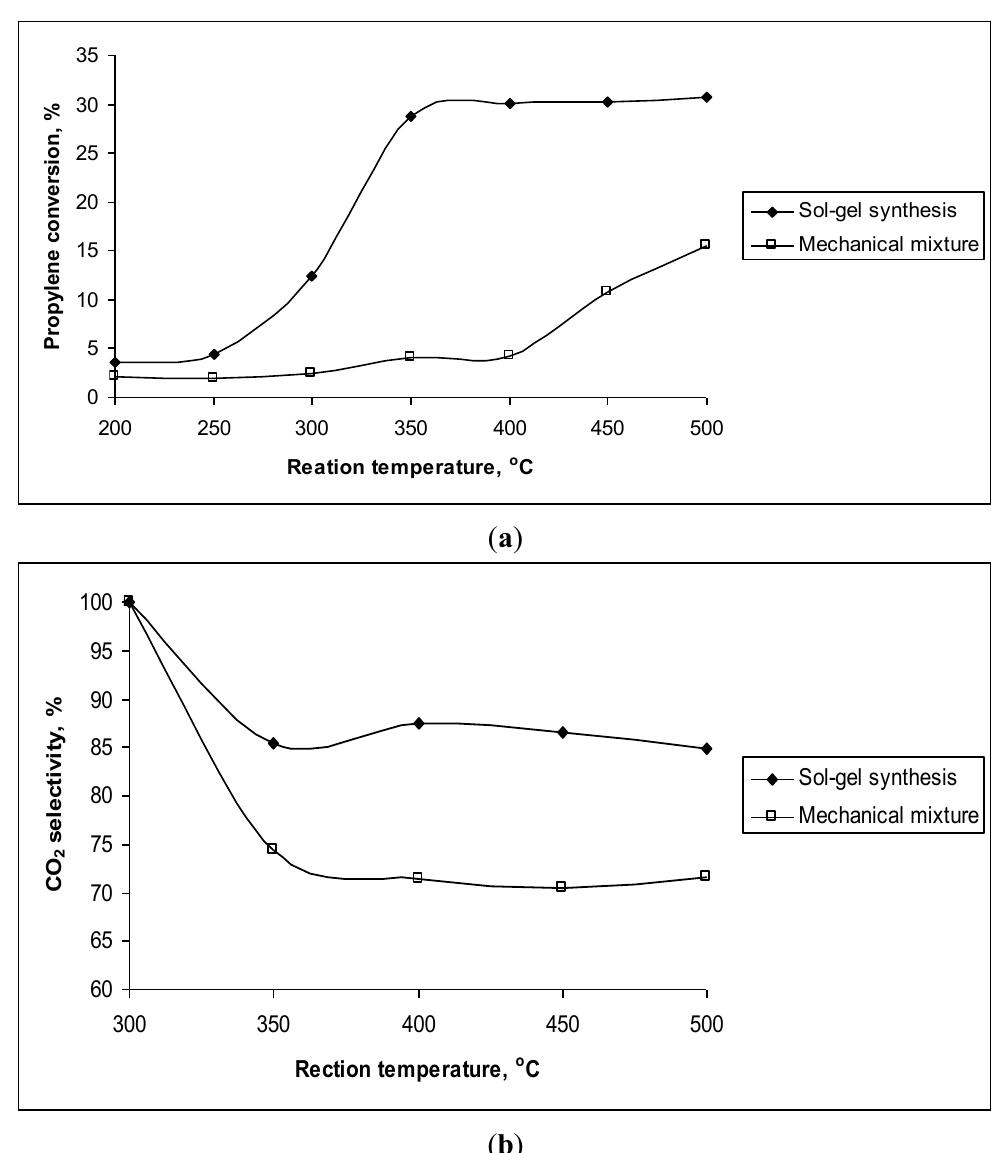
Figure 3. ( a ) Propylene conversion (%) and ( b ) CO 2 selectivity (%) of the mixture containing 80% mol CeO 2 synthesized by mechanical mixing and sol-gel method (Ce 0.8 Zr 0.2 O 2 ) at different reaction